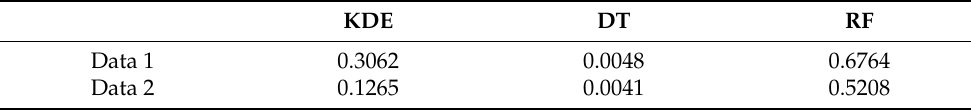
Table 3. Execution times (in s) on the synthetic datasets.